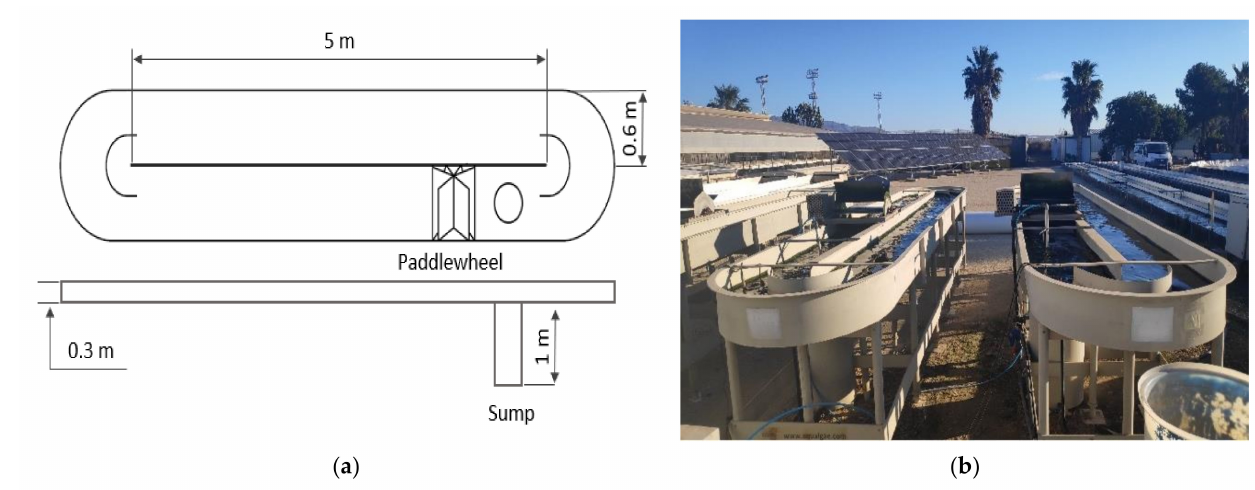
Figure 2. Raceway photobioreactors. ( a ) scheme (top and side view); ( b ) raceway